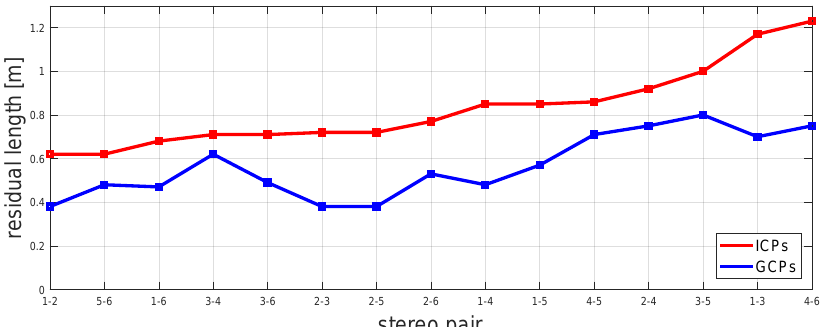
Figure 18. The 3D length discrepancies for the Ljubljana set sorted from lowest to highest ICP error. ICP values are given in red and corresponding GCP values in